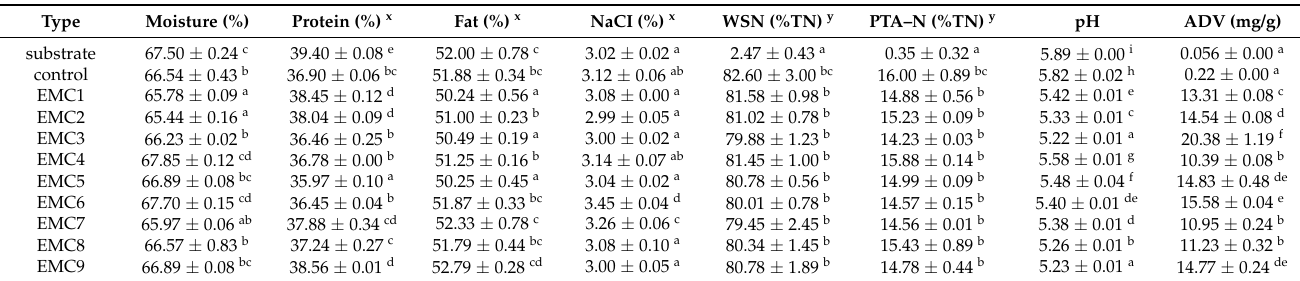
Table 1. General composition and hydrolysis indicator of the curd substrate, control, and EMCs (EMC1-EMC9).